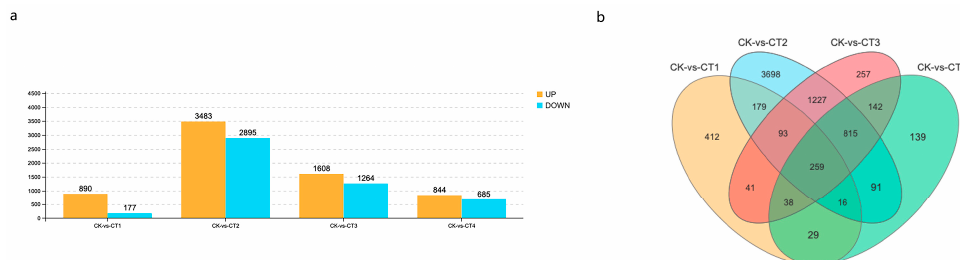
Figure 3. ( a ) Numbers of differentially expressed genes (DEGs) in the transcriptome of ‘Jinguang’ pear flowers. ( b ) Venn diagram of DEGs among cold treatment groups.